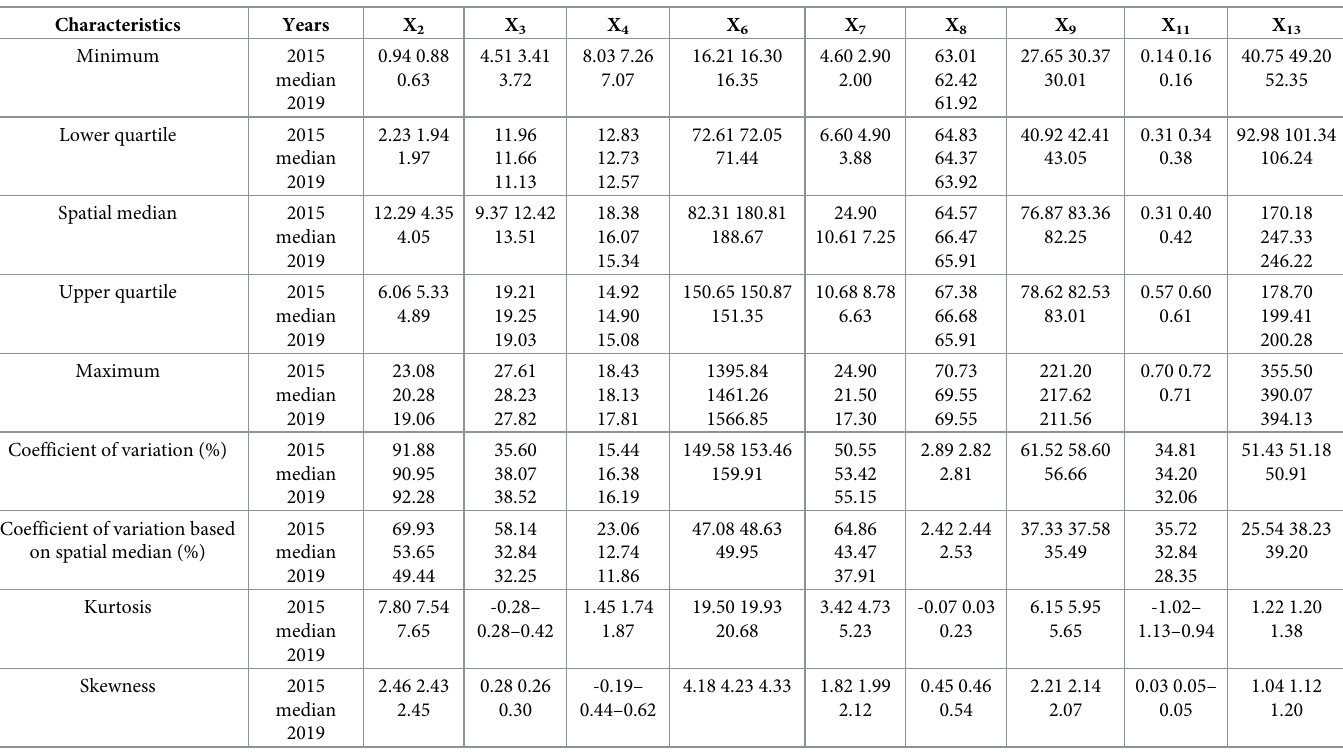
Table 3. Basic descriptive statistics characterising the diagnostic features for EU-28 countries. Characteristics